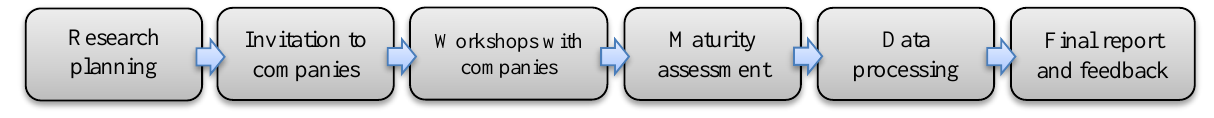
Figure 1. Steps of research